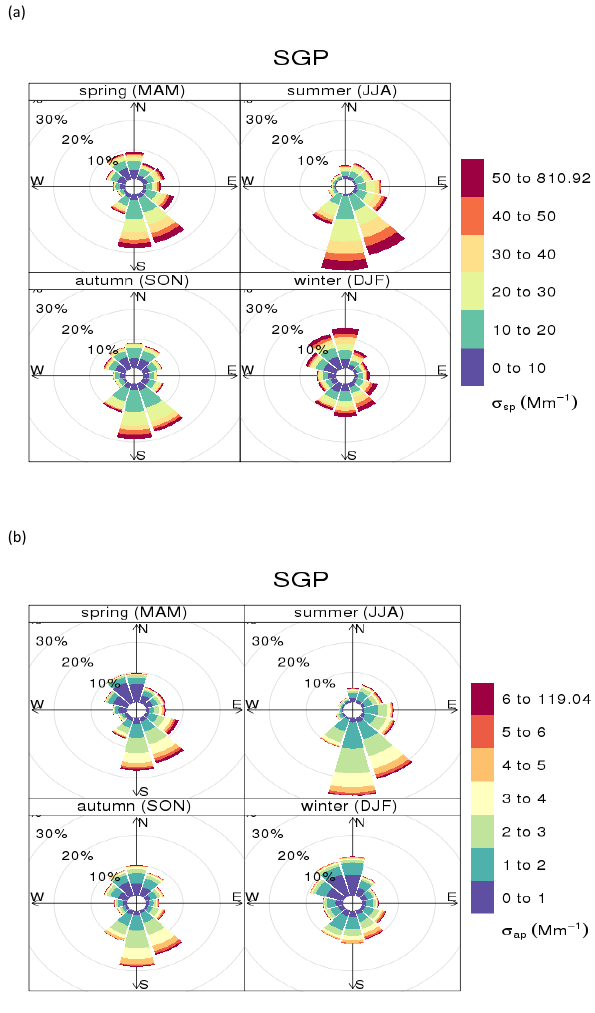
Figure 8. Pollution rose diagrams of PM 1 σ sp and σ ap for individual seasons at SGP over the 2010–2013 period. The percentages at a given radius represent the percentage of hourly profiles for a given wind